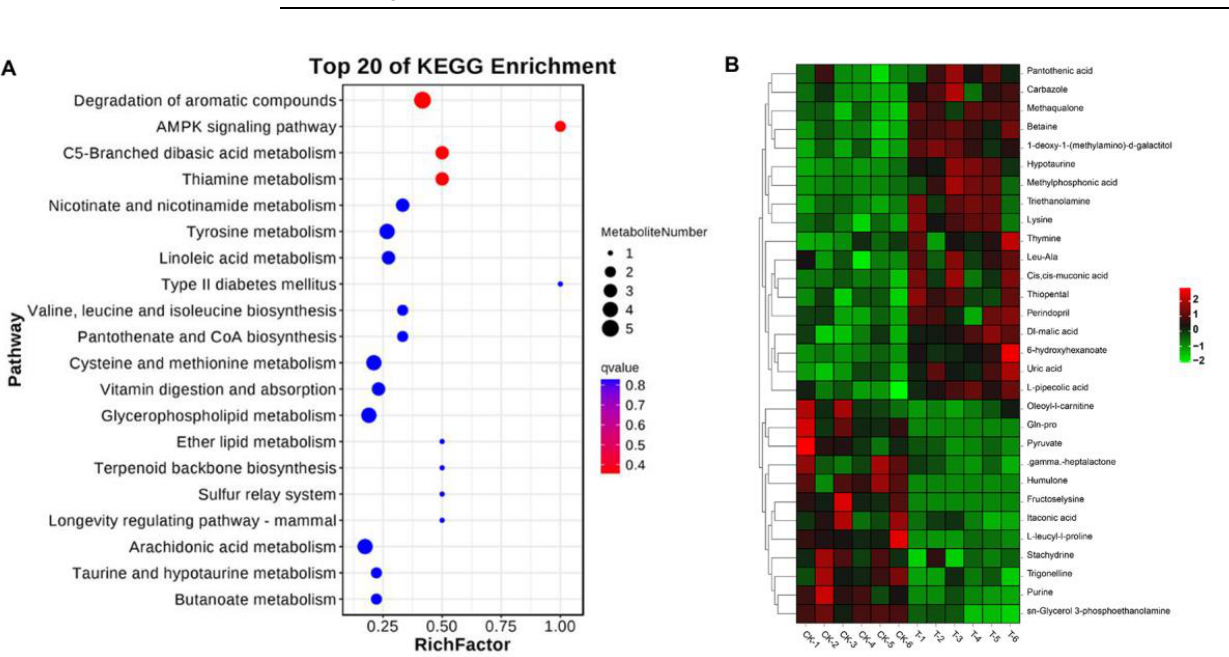
Figure 6. Identification of significantly differential metabolites in Palaemon carinicauda after EHP infection. ( A ) Enriched metabolic pathways associated with EHP infection. ( B ) Heatmap of 30 significantly differential metabolites after EHP infection (VIP scores of the top 15 metabolites in positive and negative ion mode).